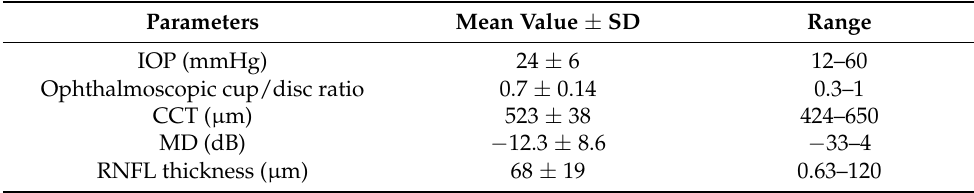
Table 3. Baseline ophthalmological parameters describing the glaucoma condition of the enrolled patients in the XEN-GTR.